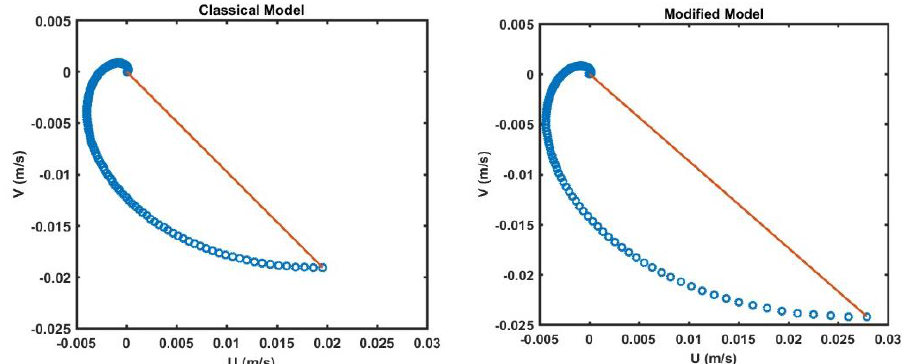
Figure 10. The Ekman spiral for the classical model is presented on the left side, while the modified Ekman model is shown on the right side. It is clear that the Ekman spiral in the modified model presents higher velocity components.